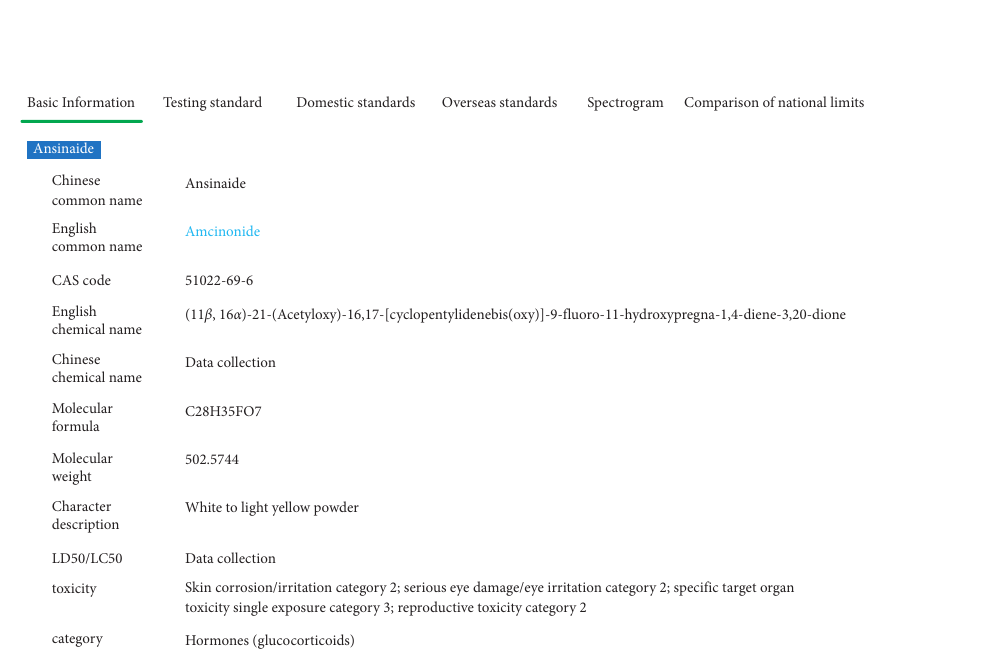
Figure 6: Detailed comparison page of screening results (molecular structure diagram). (a) 3D conformer. (b) 2D structure.